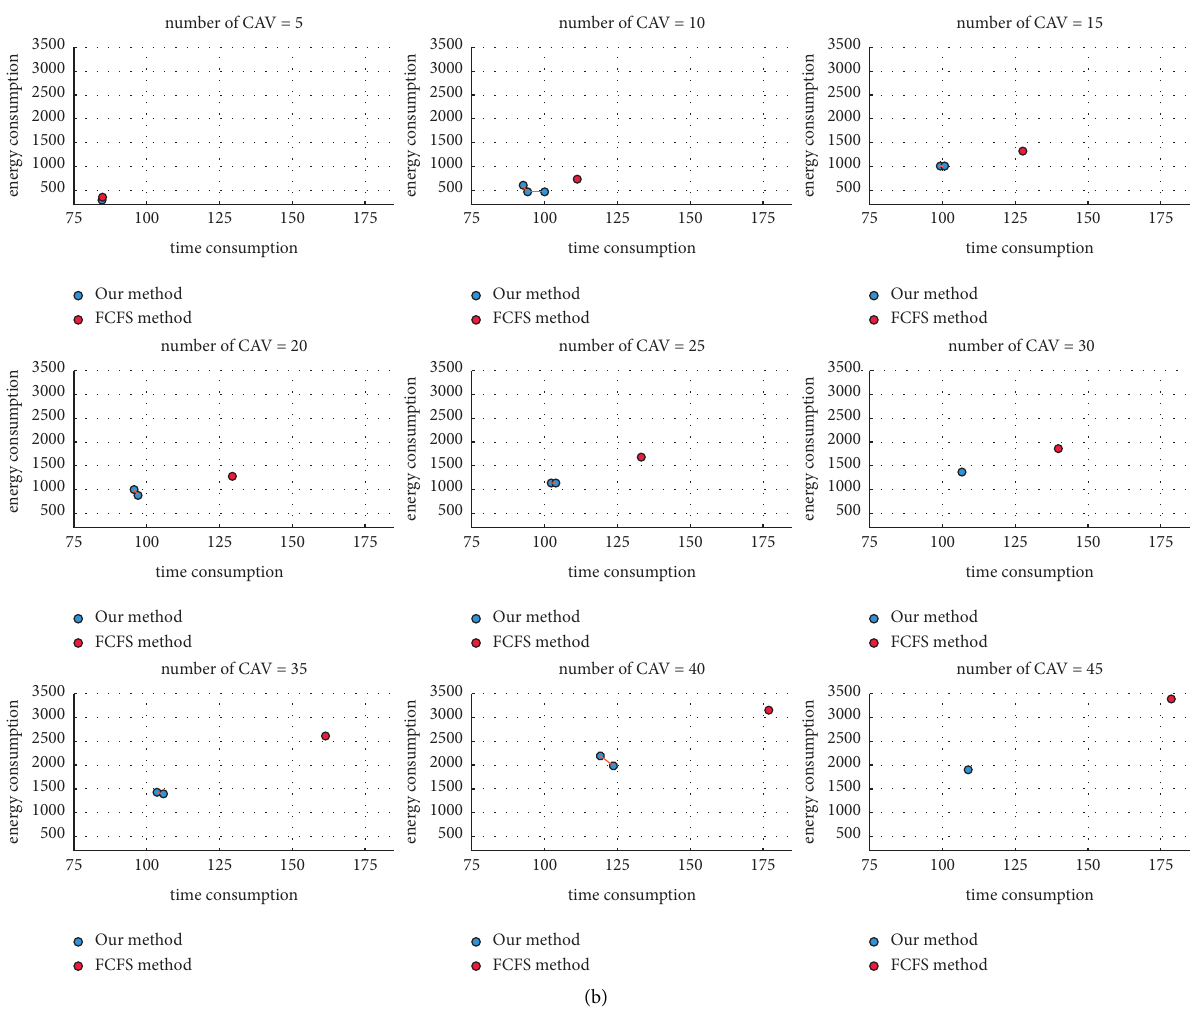
Figure 7: Performance of the proposed framework compared with FCFS strategy under different CAV number circumstances. (a) For on-ramp scenario and (b) for intersection